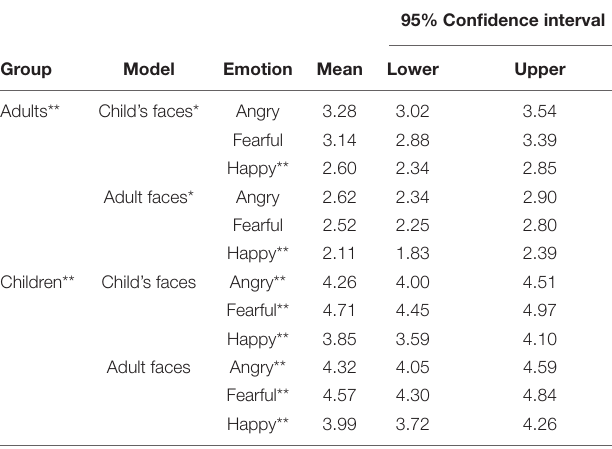
TABLE 1 | Descriptive statistics of the search times in seconds for child and adult participants’ search task (angry, fearful, and happy) on faces of children and